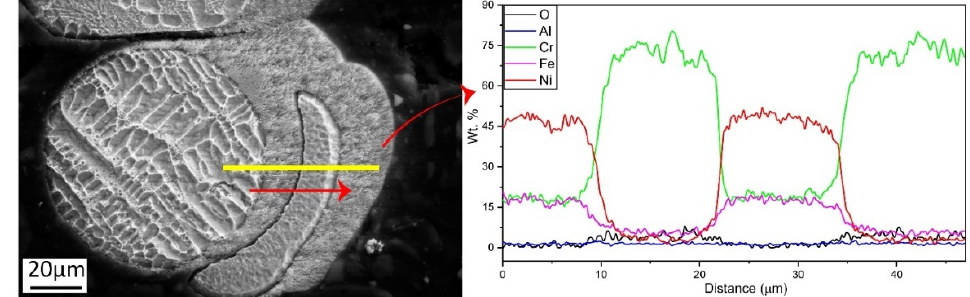
7 of 12 Figure 4. A comparison of condensate deposited on the surface of spatters: ( a ) spatter particle with-